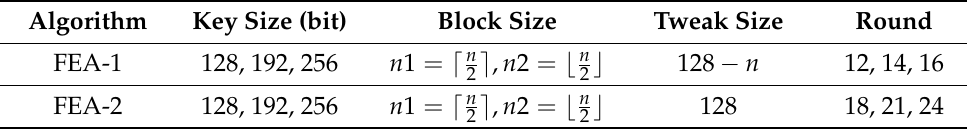
Table 1. Parameters of FEA-1 and